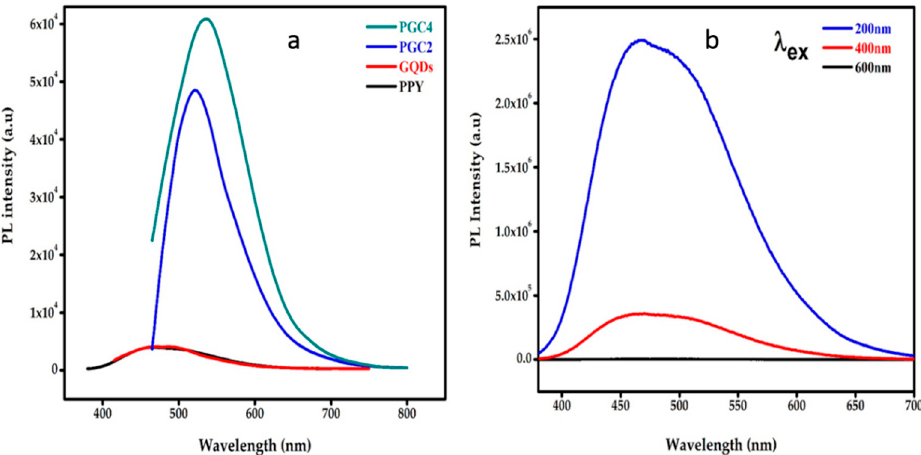
Figure 5. Photoluminescence of the ( a ) PPy, GQDs, and PGC composites (PGC2, PGC4) for the same excitation wavelength. ( b ) PL spectra of pure GQDs at various excitation wavelengths ( λ ex ).